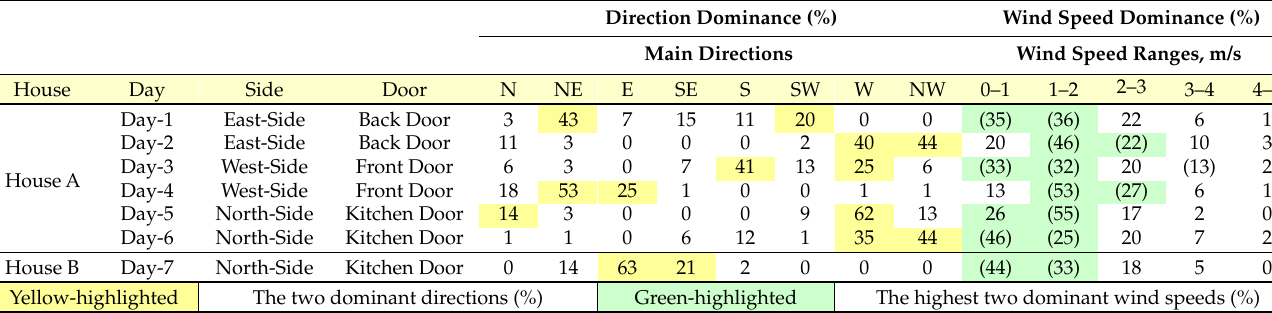
Table 6. Dominant wind direction and speed in House A and House